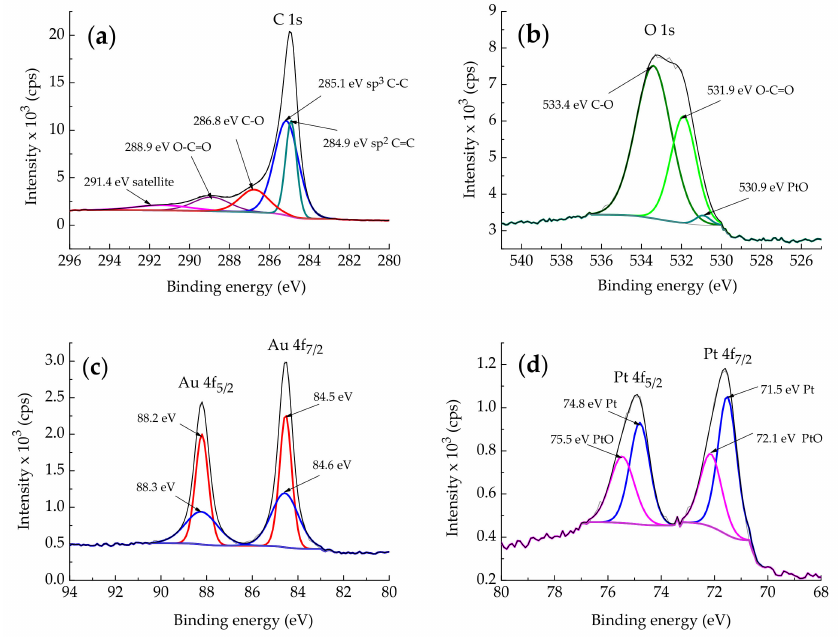
Figure 4. High-resolution XPS spectra for PtAu/rGO constituents showing the following deconvo- luted peaks: ( a ) C 1s; ( b ) O 1s; ( c ) Au 4f; and ( d ) Pt